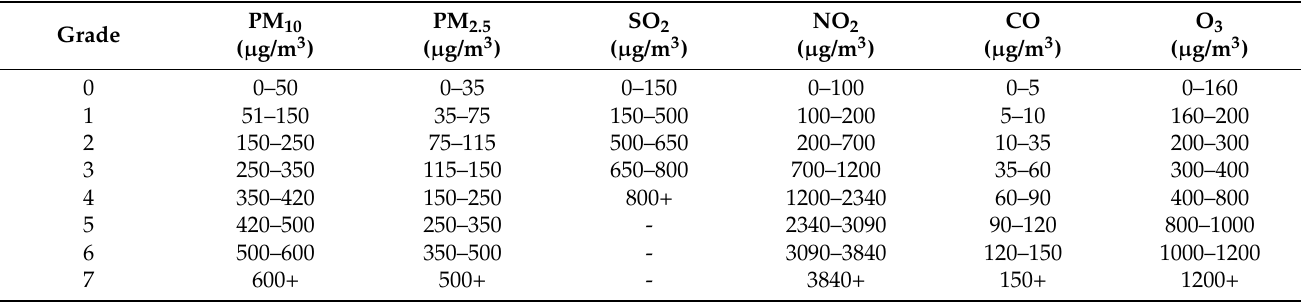
Table 2. The partitions of air pollution quality